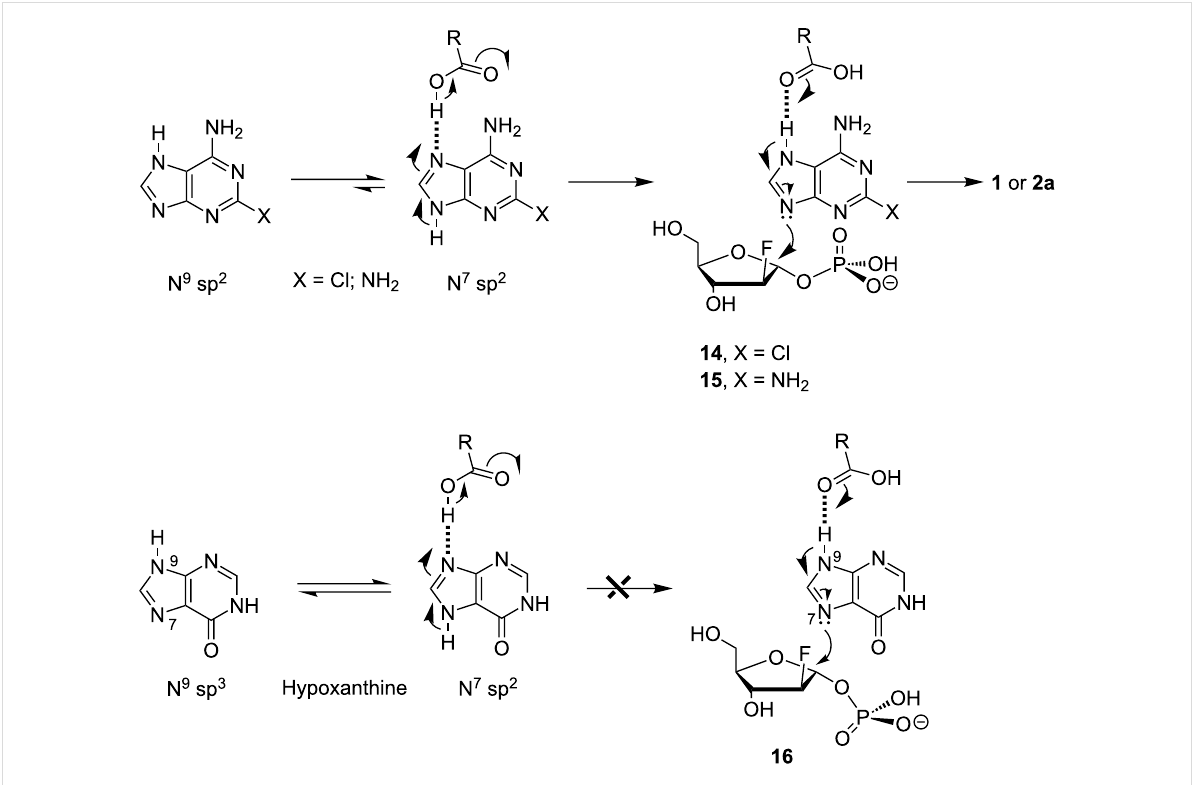
Scheme 2: Suggested mechanism of purine nucleoside synthesis catalyzed by E. coli purine nucleoside